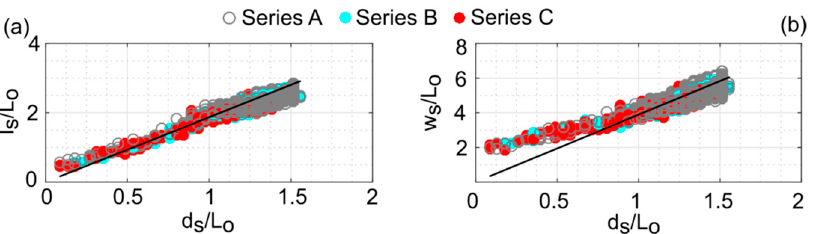
Figure 14. Dependence of nondimensional geometrical length scales on nondimensional scour hole depth in different experimental series: ( a ) scour hole length and ( b ) scour hole width.